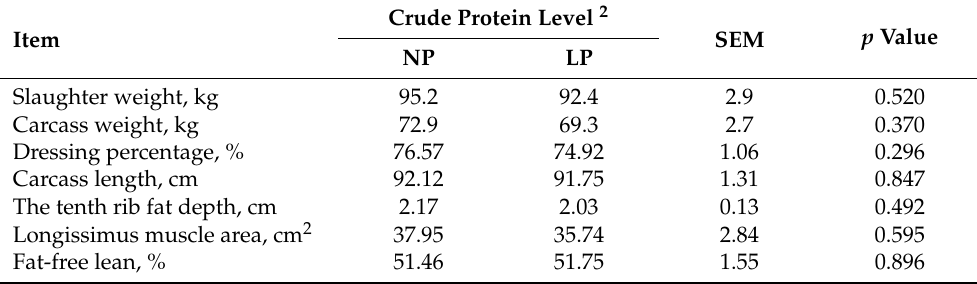
Table 3. Ingredient composition of the experimental diets (%, as-fed basis) 1 .